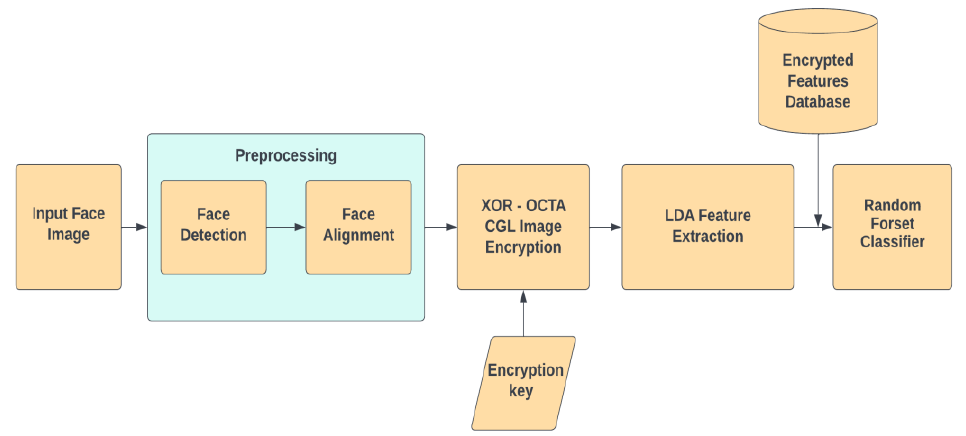
Figure 4. LDA Face Recognition scheme with Encrypted Face Images. Random forest classifier, introduced in 2001 by Leo Breiman [42] consists of indepen- dent set of decision trees that collectively classify input data based on majority votes [43]. In random forest classification random samples are selected from training set and an indepen- dent decision tree is generated for each sample. Each decision tree outputs its prediction and based on majority votes for predications a classification output is